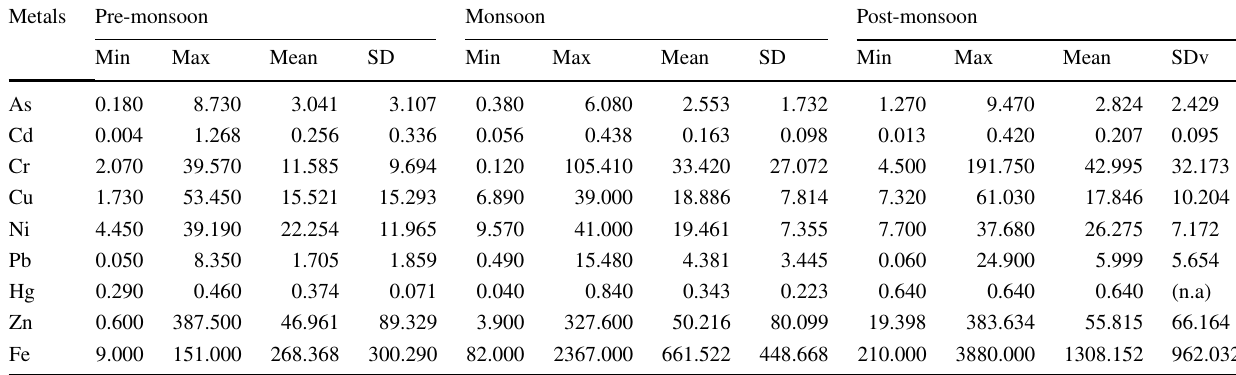
Table 4 Seasonal variation in heavy metal concentrations in water samples of Mahanadi River